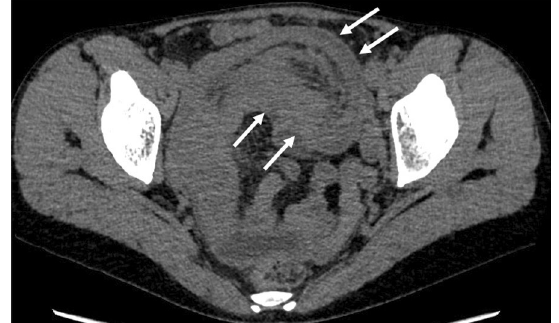
Fig. 3 Computed tomography findings on the second admission. Computed tomography revealed the recurrence of jejunal intussusception (white arrows) without any free air or